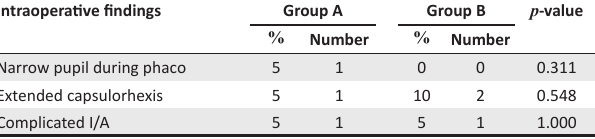
TABLE 5: Phaco Group A versus phaco Group B.